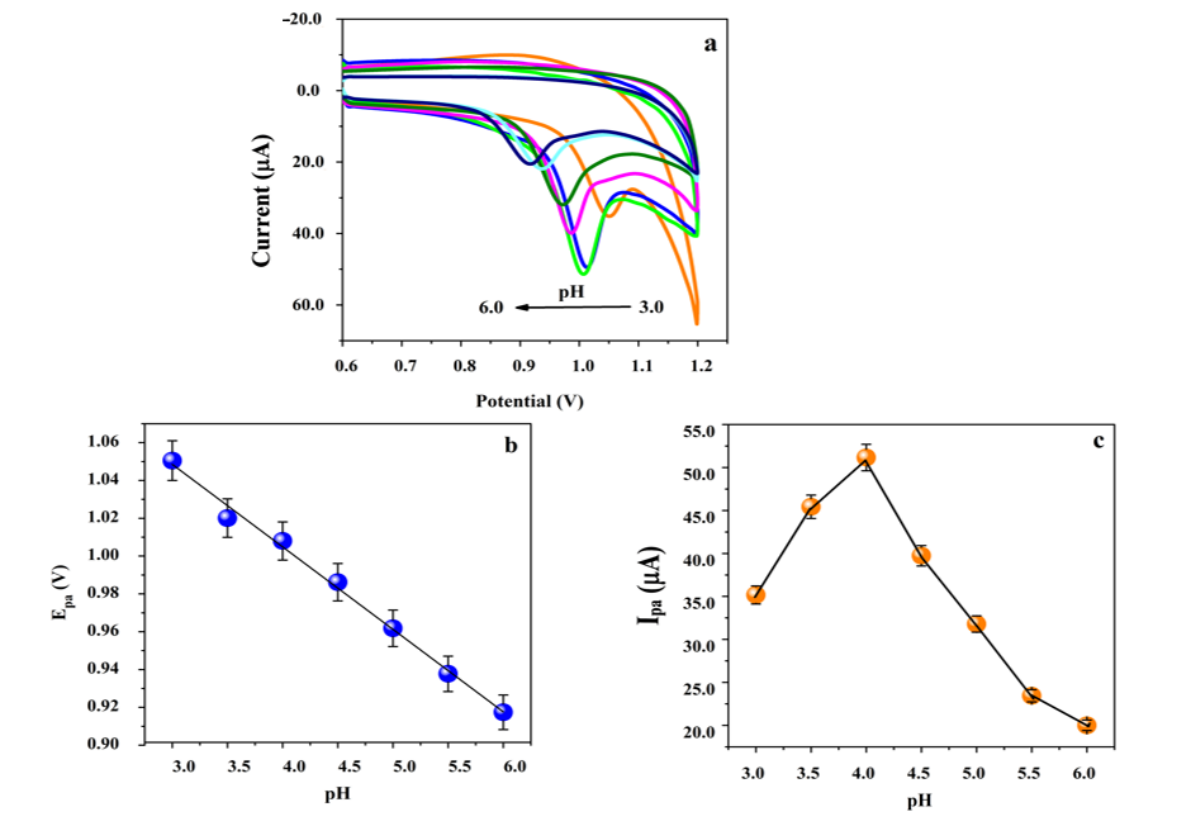
Figure 6. ( a ) CVs of 0.1 mM LN in 0.2 M PBS with pH ranging from 3.0 to 6.0 measured at 0.1 Vs − 1 scan rate. Plots of ( b ) E pa vs. pH and ( c ) I pa vs. pH.